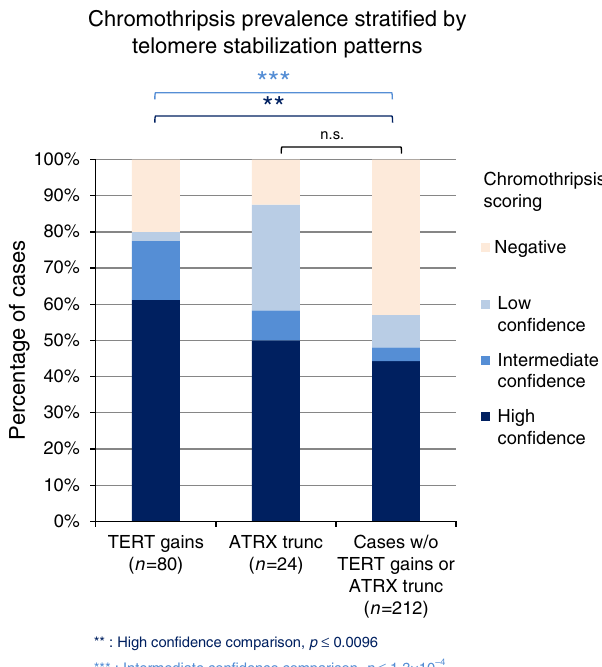
Fig. 5 Chromothripsis is associated with speci fi c telomere features. Cases with gains of TERT ( n = 80) or with truncating mutations in ATRX ( n = 24, ATRX being strongly linked with activation of the Alternative Lengthening of Telomeres pathway) are enriched in chromothripsis- positive tumours as compared to tumours without TERT gain and without ATRX mutation ( n = 212). Statistical analysis was tested using chi squared tests to compare the proportions of tumours with chromothripsis (high- con fi dence or intermediate-con fi dence). ATRX trunc, tumours with truncating mutations in ATRX